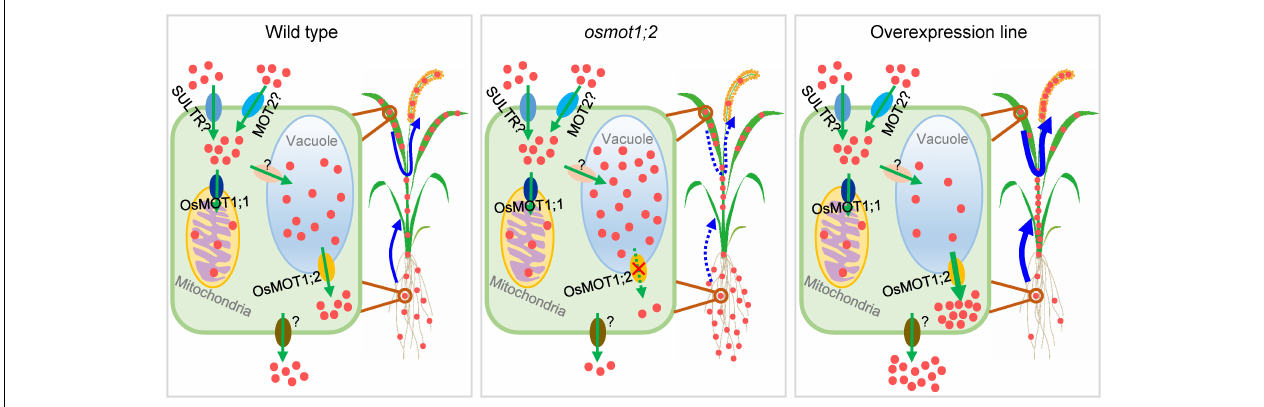
FIGURE 7 | Proposed model of potential roles of OsMOT1;2 in controlling cellular Mo homeostasis and remobilization of Mo in rice. Mo is taken up into cells in the form of molybdate (red dots in the figures) likely through molybdate transporter family 2 protein (MOT2) and/or non-specifically by sulfate transporters (SULTR). Molybdate is then transported into mitochondria by OsMOT1;1 or into vacuoles by unknown transporter(s). OsMOT1;2 functions as a molybdate exporter to mediate the efflux of Mo from vacuoles to the cytosol, which is further transported out of cells for remobilization by unidentified transporter(s). Knockout of OsMOT1;2 reduces the efflux of Mo from vacuoles, resulting in less Mo being translocated from roots to shoots and from leaves to grains. In contrast, overexpression of OsMOT1;2 promotes the efflux of Mo from vacuoles and enhances the root-to-shoot translocation and the remobilization of Mo from leaves to grains during filling stage and thus increasing the Mo accumulation in